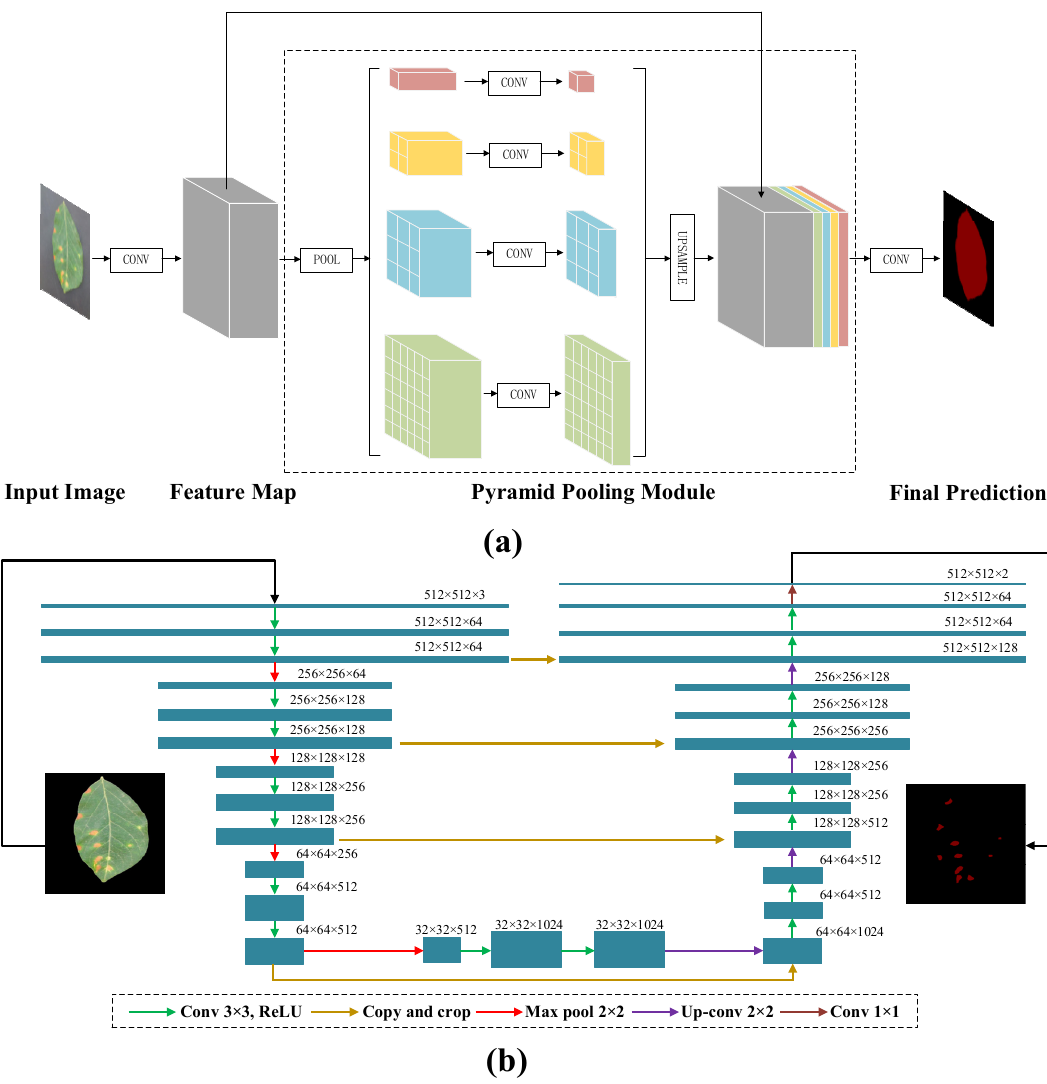
Figure 2. The structure of ( a ) pyramid scene parsing network (PSPNet) and ( b ) UNet. The selected neural networks were trained by the cropped images (512 × 512) obtained from the original images and then cut with multiple scales. and then cut with multiple